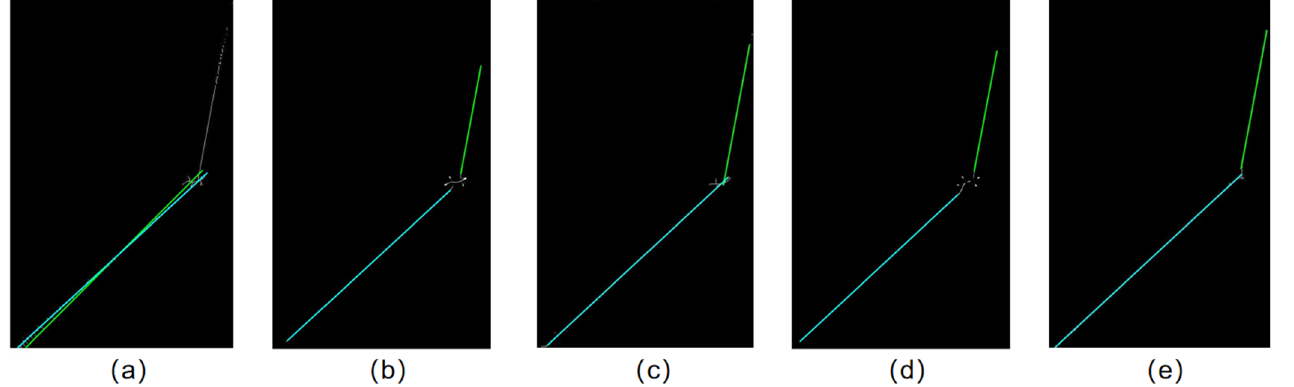
Figure 11. Linear extraction results after various skeleton extraction algorithms: ( a ) morphological erosions; ( b ) the Steger algorithm; ( c ) the Zhang–Suen algorithm; ( d ) closing operation with the Steger algorithm; ( e ) dilation with the Zhang–Suen algorithm.